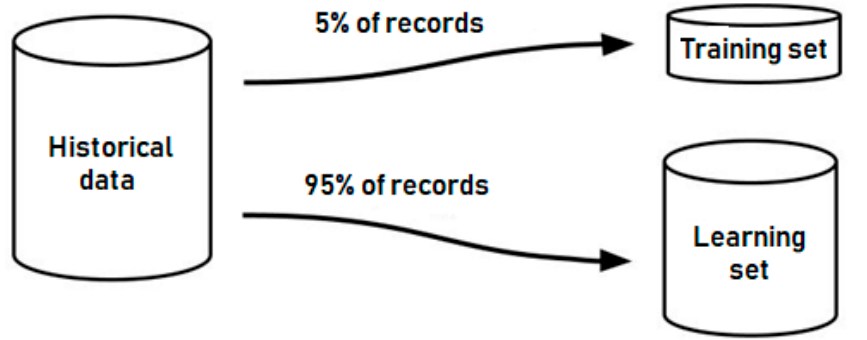
Figure 1. A scheme of historical data distribution between the test and educational datasets.